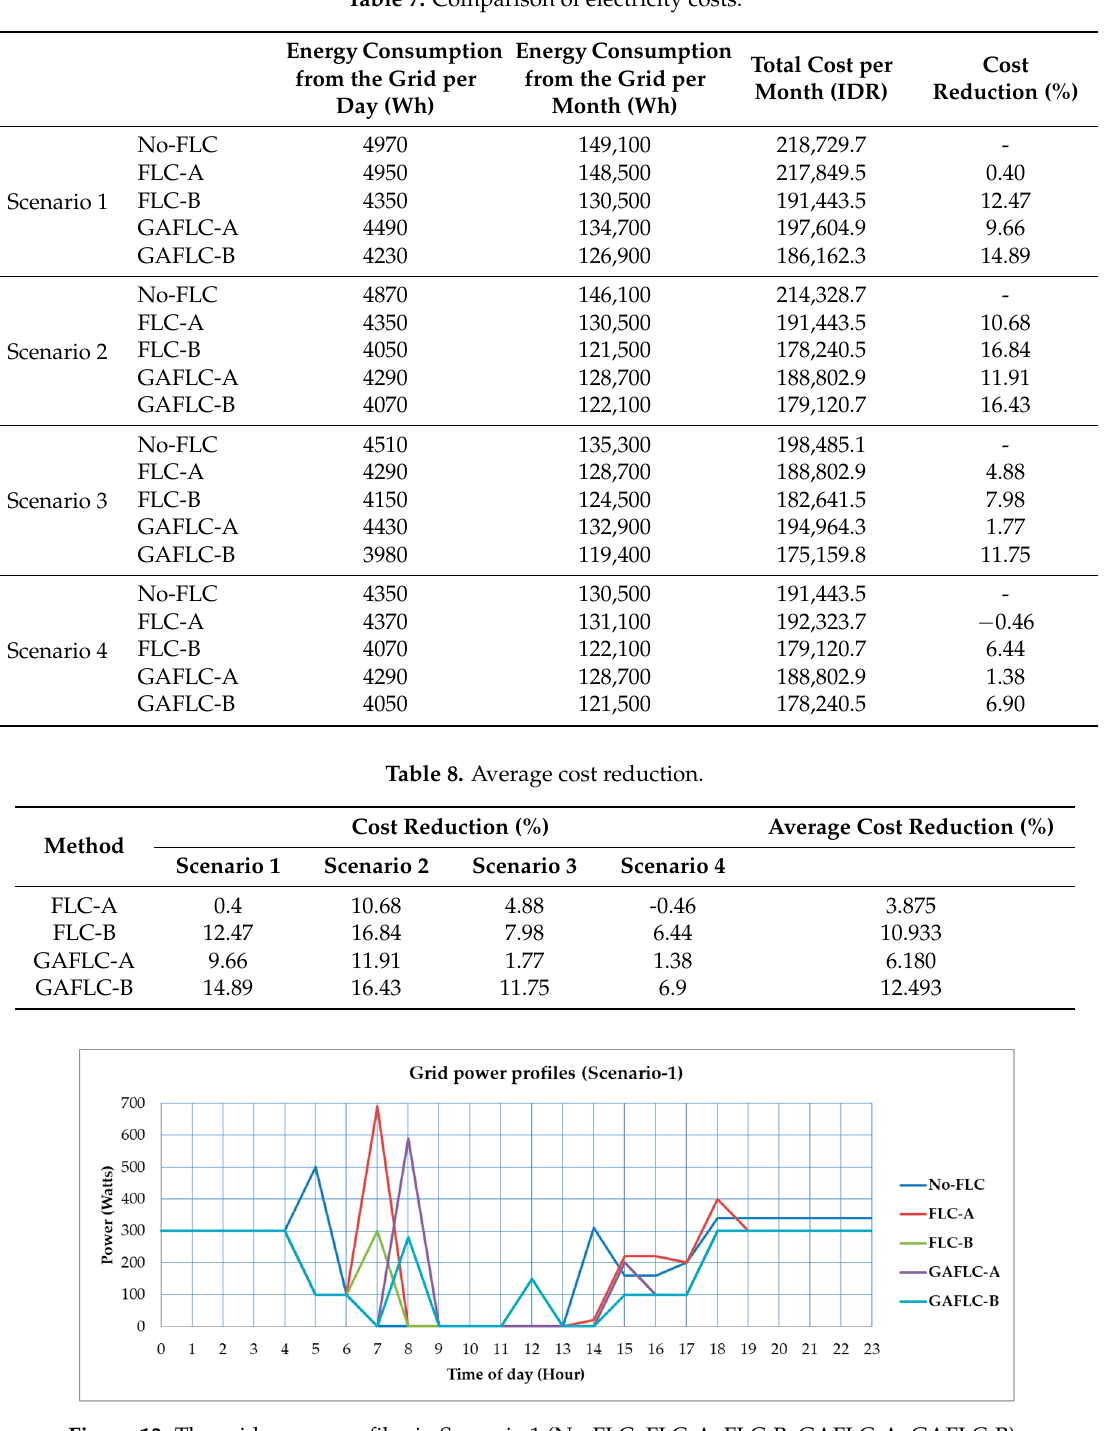
Table 7. Comparison of electricity costs.